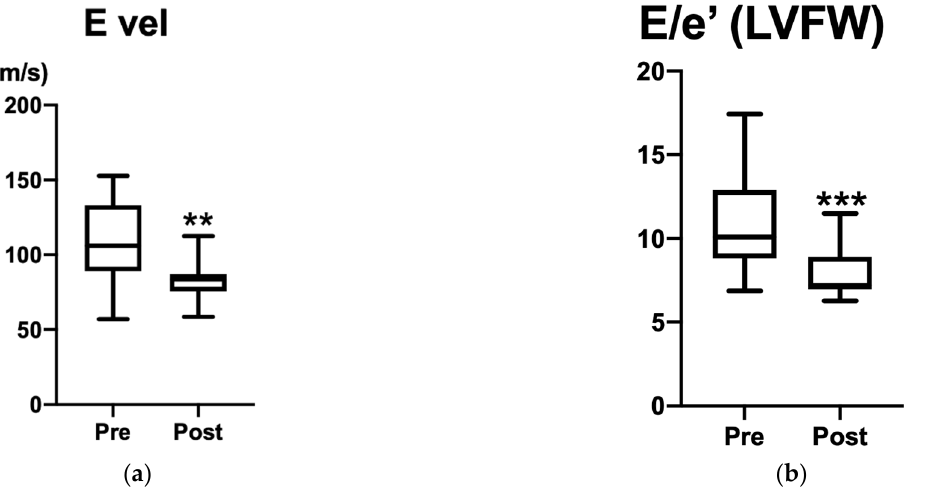
Figure 1. Echocardiography parameters: ( a ) E vel (cm/s) and ( b ) E/e’ at LVFW. E velocity is shown in ( a ) and E/e’ is shown in ( b ). Significant differences are indicated by ** ( p = 0.0024) and *** ( p = 0.0008). FS and E/e’ at septal were not significantly different between Pre and Post. Improvement in congestion was observed in all cases following PDA occlusion.